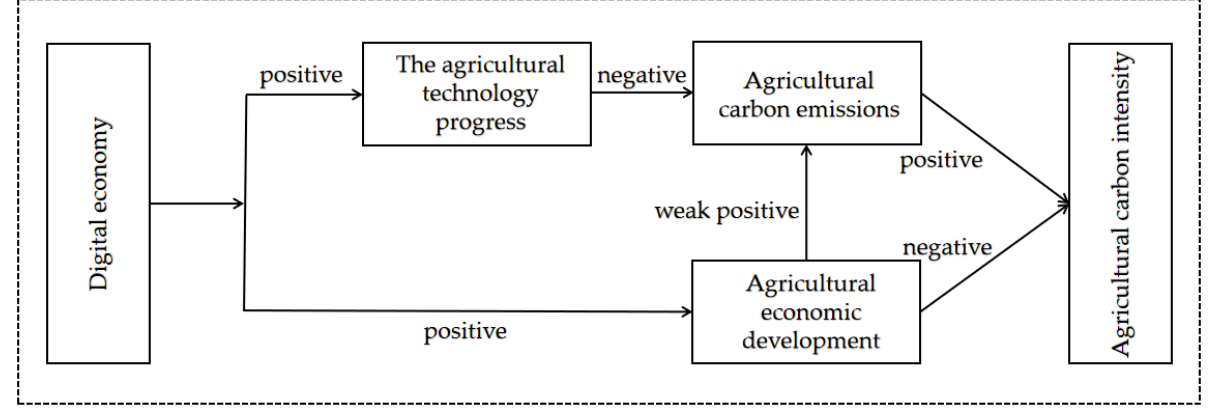
Figure 1. Mechanism path chart of the digital economy as it affects agricultural carbon intensity.